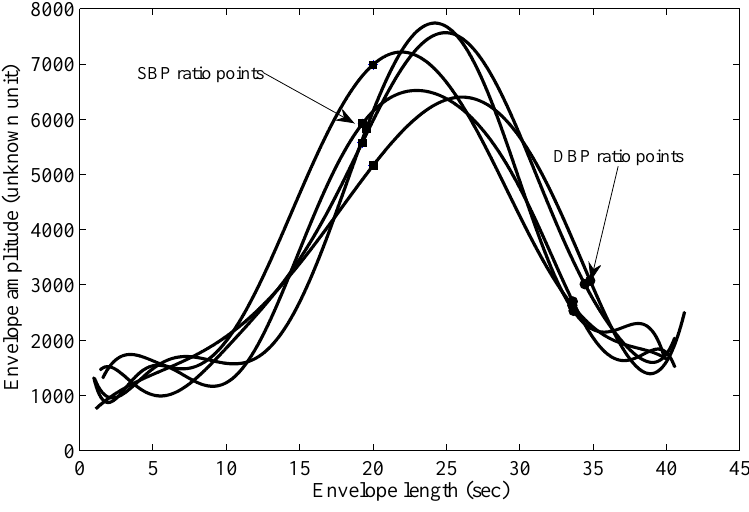
Figure 3. The distribution of pseudo ratios for the SBP and DBP using the nonparametric bootstrap